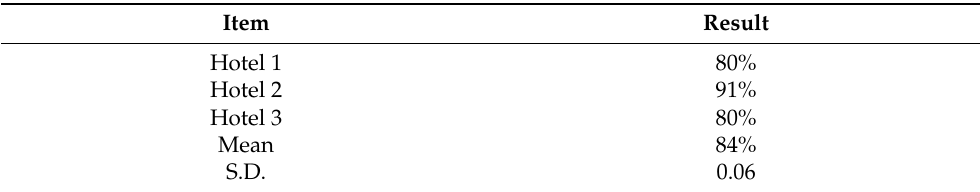
Table 12. What occupation average levels, as a percentage, did you have before the start of the COVID-19 pandemic? Item Result Hotel 1 80% Hotel 2 91% Hotel 3 80% Mean 84% S.D. 0.06